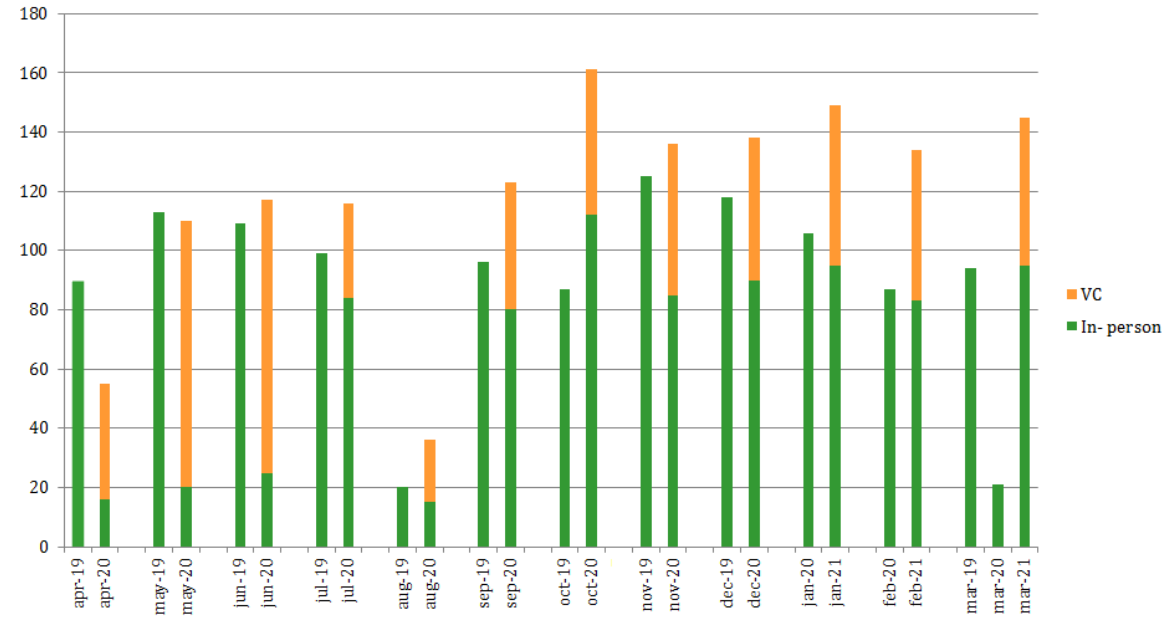
Figure 5. Numbers of visits performed per month (including both “in-person” and video consults, VC) over all retrospectively analyzed time periods (April 2019–March 2021).